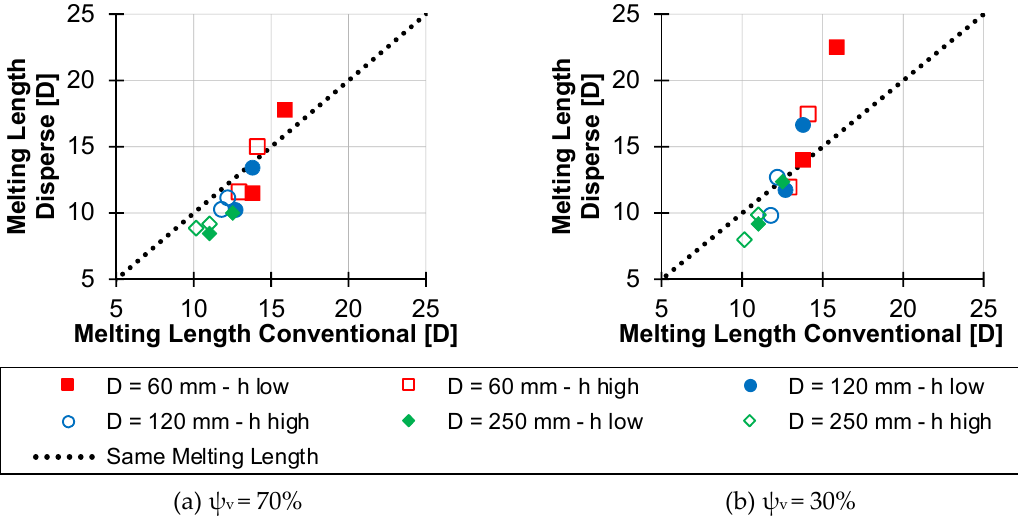
Figure 19. Comparison of conventional melting length and the disperse melting length for initiating disperse melting at a solid volume content of ( a ) ψ v = 70% and ( b ) ψ v = 30%.